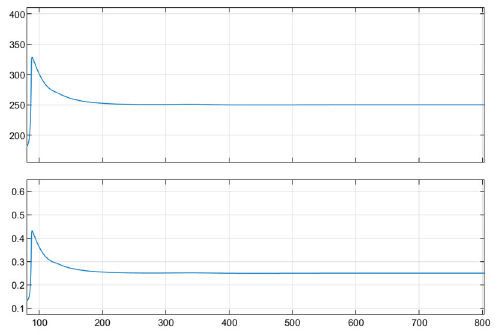
Figure 12. Output voltage and output power of microbial fuel cell stack.